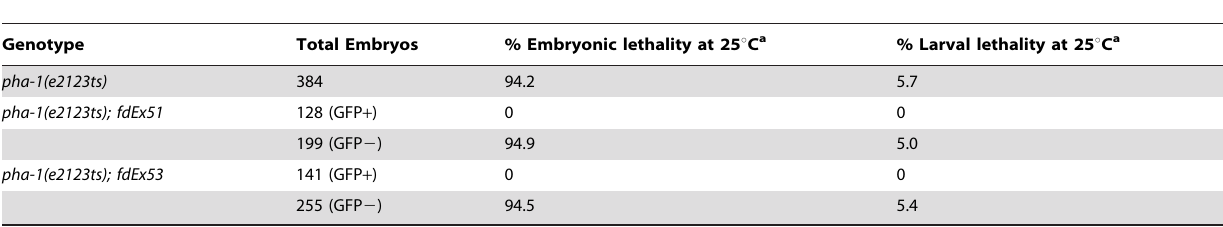
Table 2. pha-1(e2123ts) retains partial activity at non-permissive